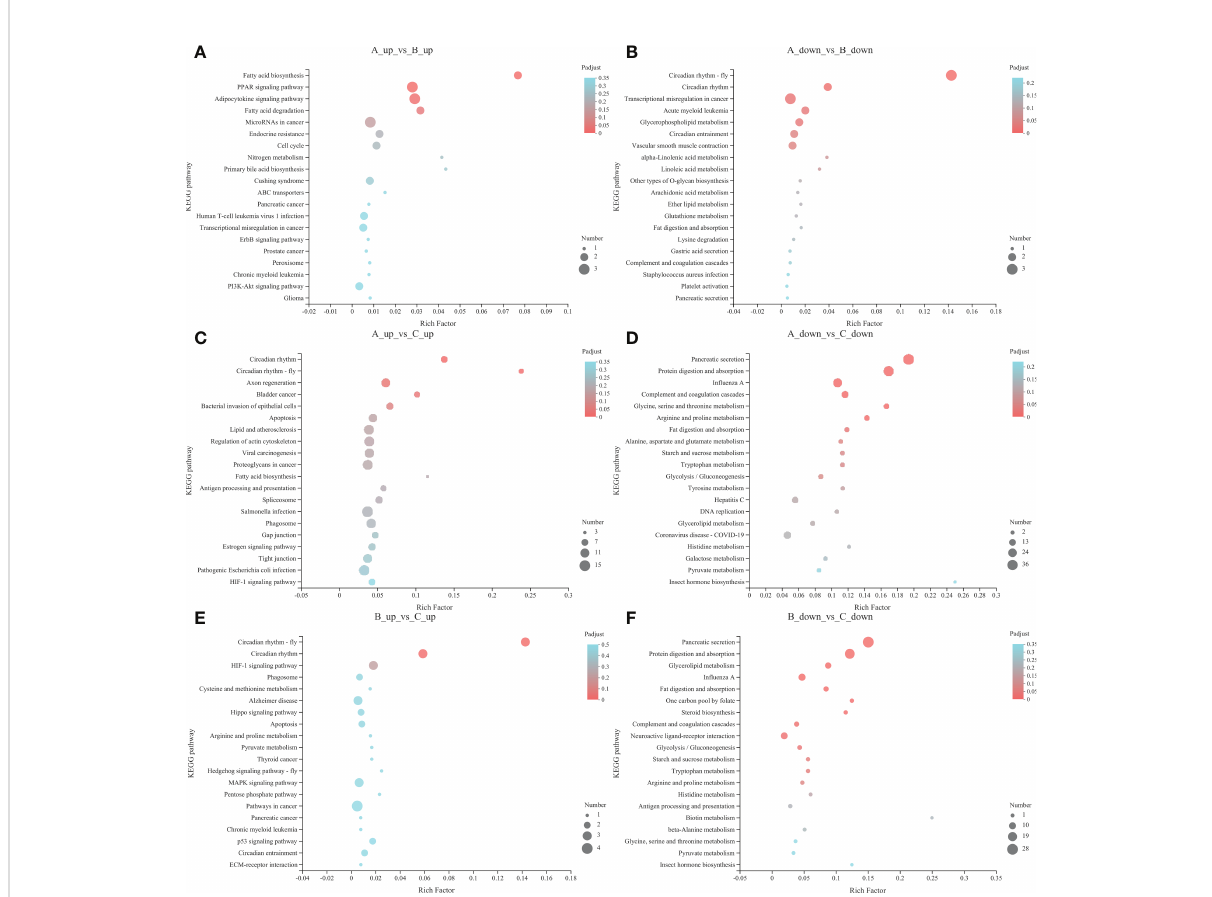
FIGURE 4 Up-regulated pathways KEGG enrichment analysis bubble diagram of 13°C group compared with 18°C group (A) , 8°C group compared with 18° C group (C) and 8°C group compared with 13°C group (E) . Down-regulated pathways KEGG enrichment analysis bubble diagram of 13°C group compared with 18°C group (B) , 8°C group compared with 18°C group (D) and 8°C group compared with 13°C group (F) . The Y-axis represents the pathway name. The X-axis represents the number of genes. The size of the points represents the number of genes in the pathway. The colors of the points correspond to different Padjust